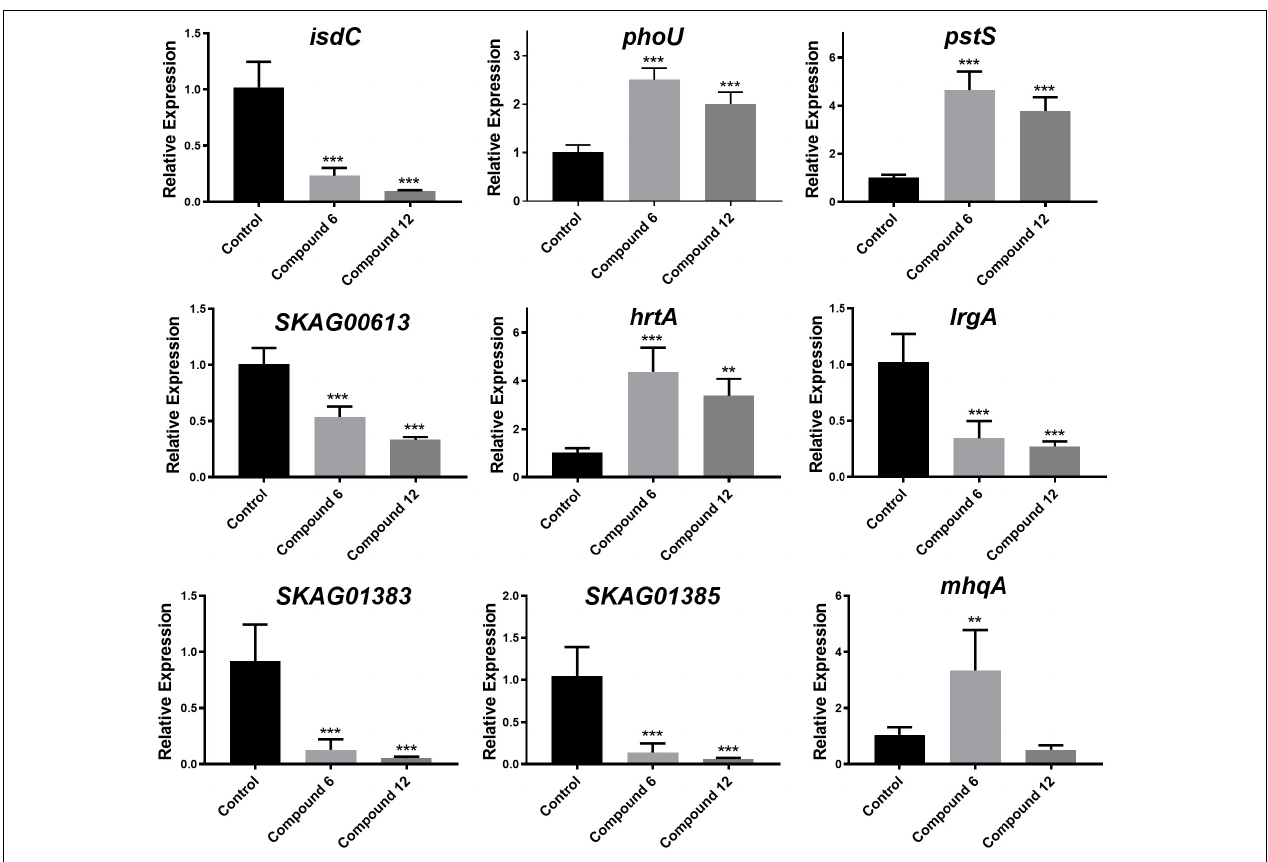
FIGURE 11 | Relative expression of nine selected genes. The data represent mean ± SD ( n = 4); *** p < 0.001, ** p <